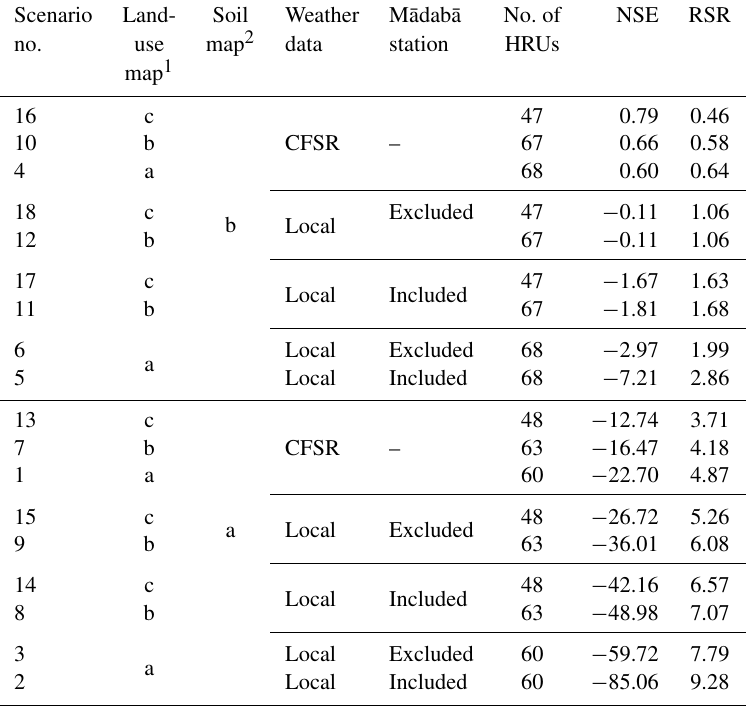
Table 2. Number of HRUs and values of NSE and RSR calculated for 18 scenarios for comparison of observed and simulated average monthly sediment yield (tmonth − 1 ) at the Wala catchment outlet. Scenario Land- Soil Weather M¯adab¯a No. of NSE RSR no. use map 2 data